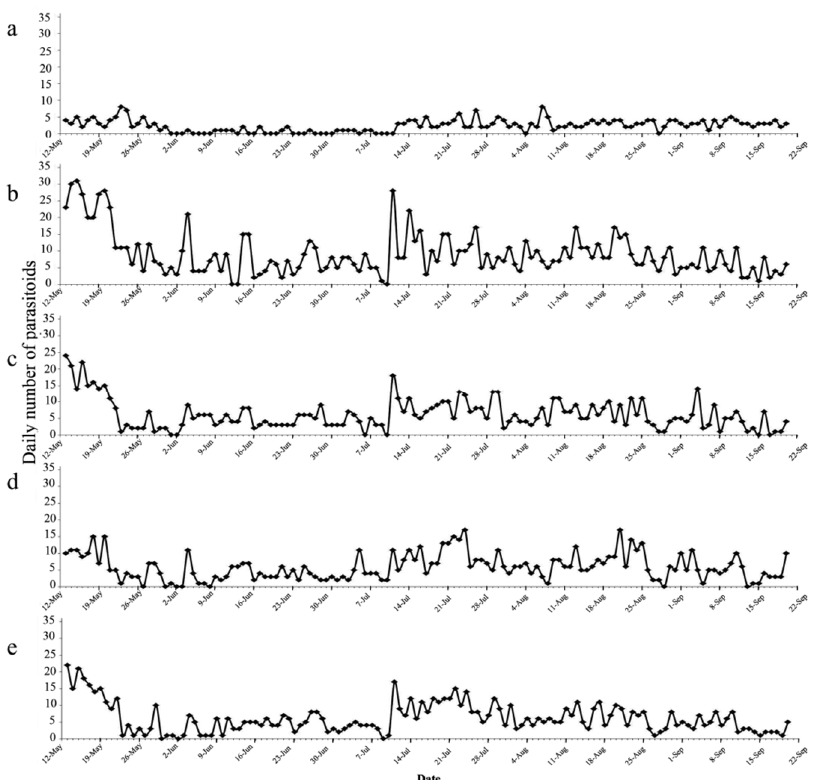
Figure 7. Numbers of parasitoids trapped/collected in the five treatments during the course of field experiment (13 May to 20 September 2015). ( a ) suction machine; ( b ) yellow sticky trap; ( c ) white light trap; ( d ) green light trap; ( e ) yellow light trap.